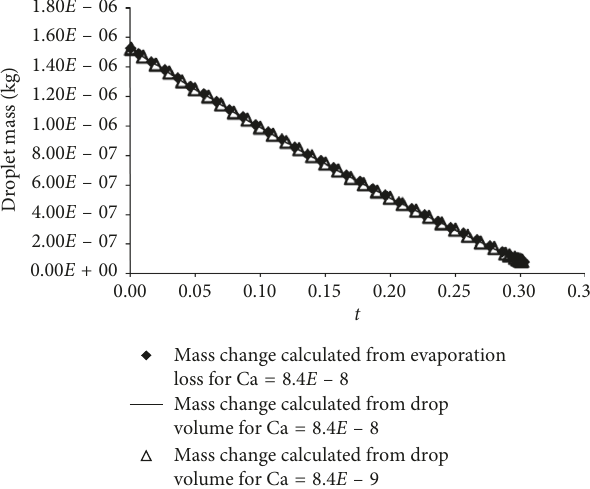
Figure 2: Comparison of mass calculation between evaporation loss and the volume integral under for Ca � 8.41 × 10 − 8 and the comparison between Ca � 8.41 × 10 − 8 and Ca � 8.41 × 10 − 9 . Initial AR �